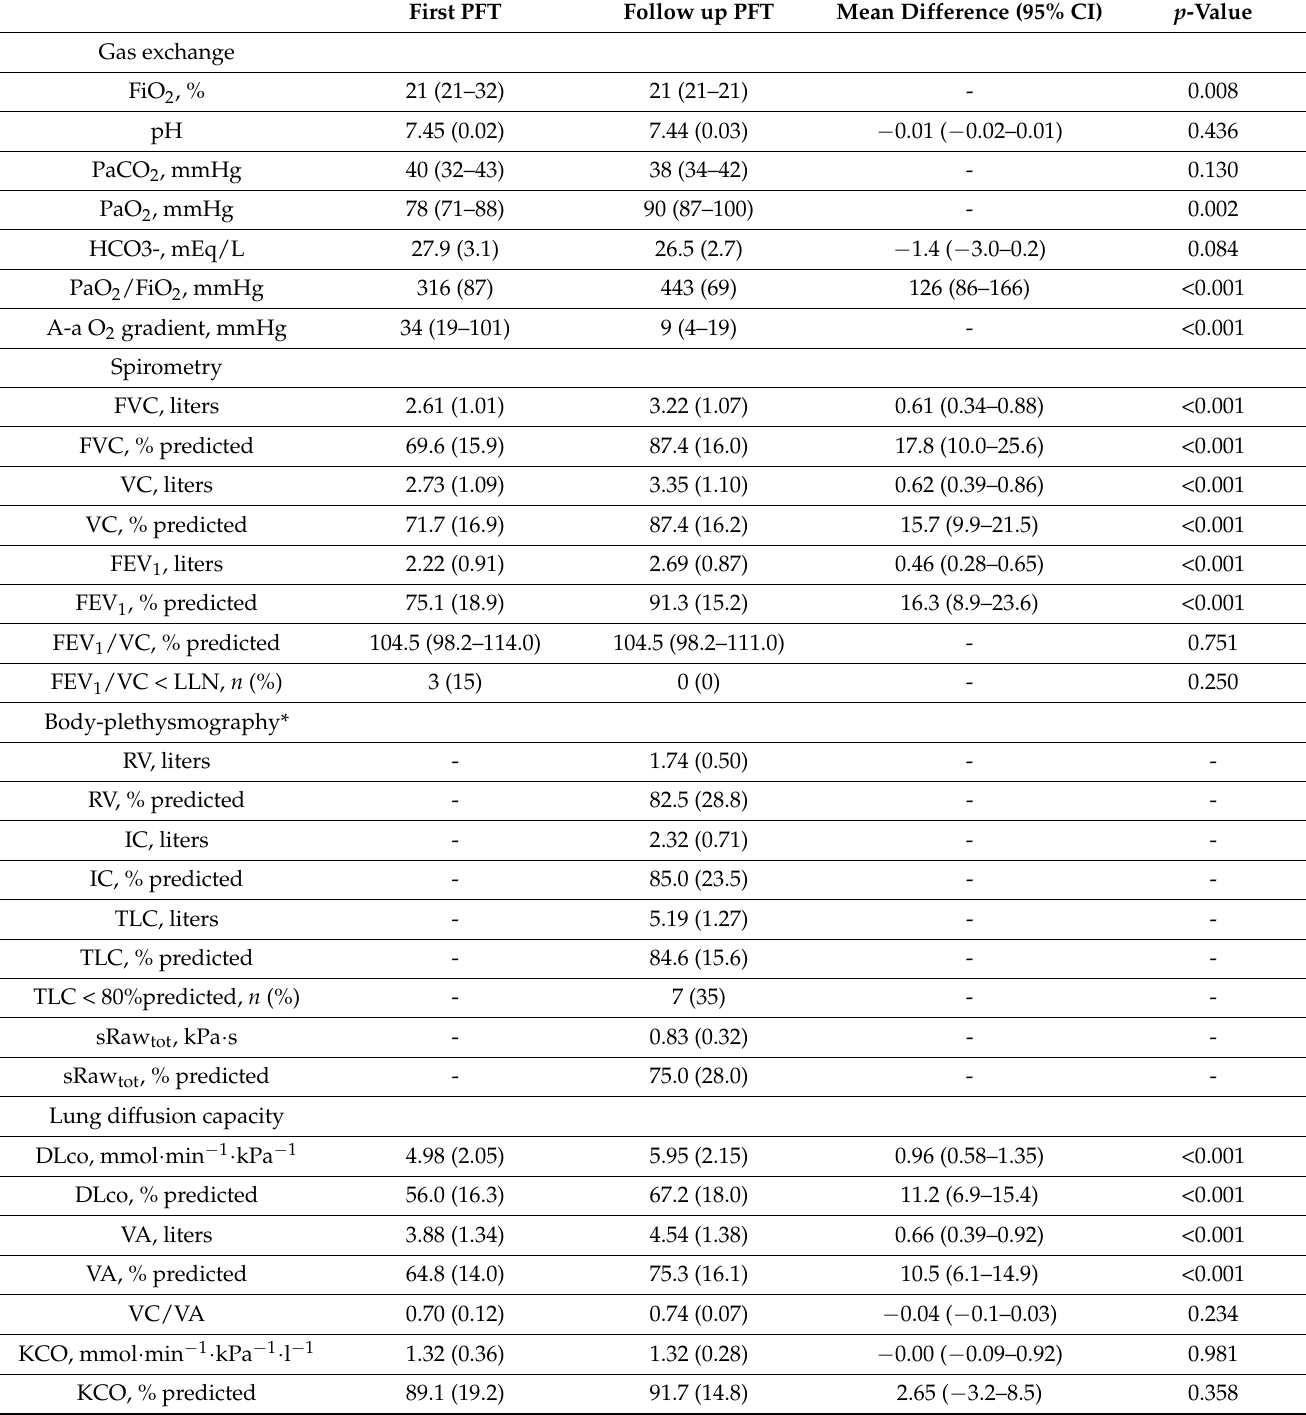
Table 2. Gas exchange and lung function during hospitalization and at the follow up